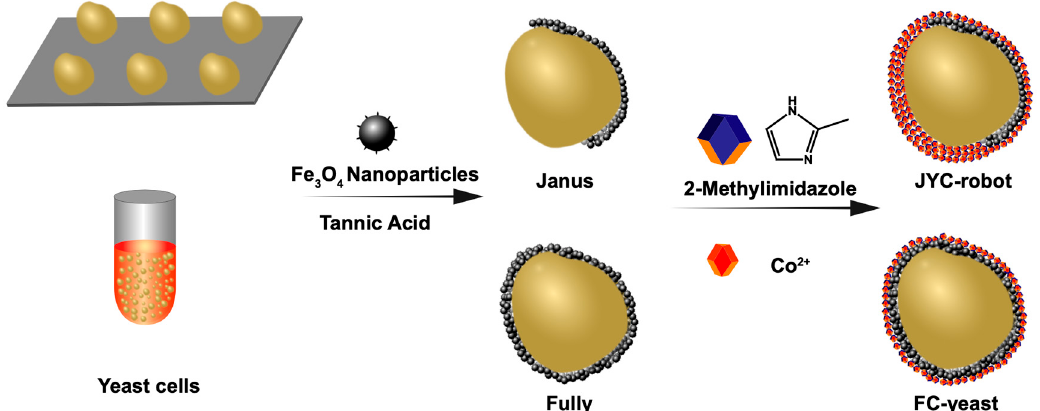
Figure 1. Schematic of the fabrication process of JYC-robots and FC-yeasts. For JYC-robots, yeast cells were first attached to the PLL-modified surface, followed with Janus modification of Fe 3 O 4 NPs through TA complexation and in situ growth of ZIF-67 by mixing with precursors of cobalt nitrate and HmIm. For FC-yeasts, yeast cells in DIW were suspended in an Eppendorf tube, followed with fully coating of Fe 3 O 4 NPs through TA complexation and in situ growth of ZIF-67.